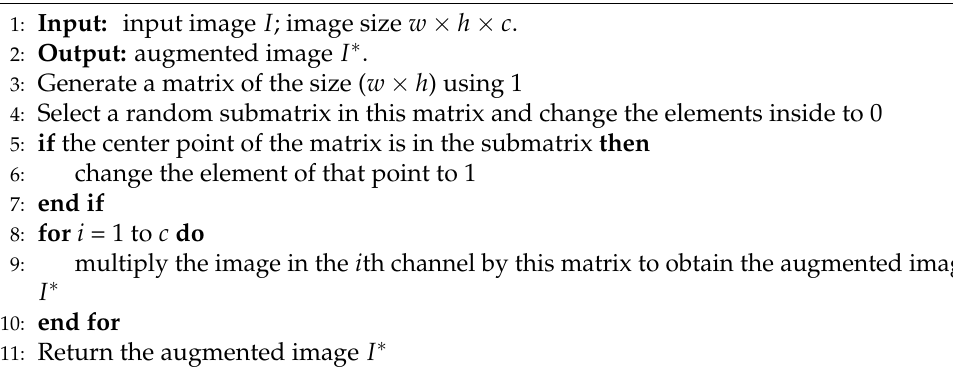
Figure 1. The augmentation methods used in our proposed method. Algorithm 1 Selecting Random Rectangular Area to Remove Spectral